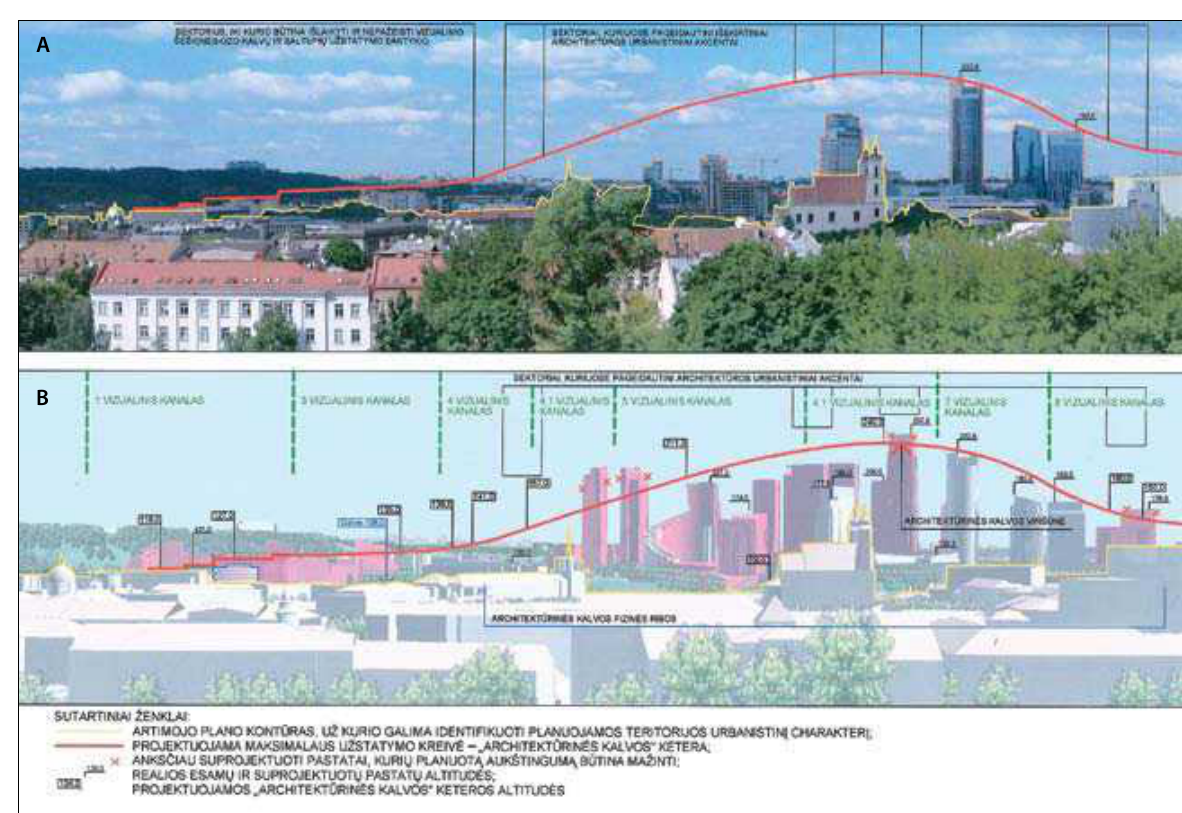
Fig 9. Model of curve for maximum height: a – existing situation; b – planned